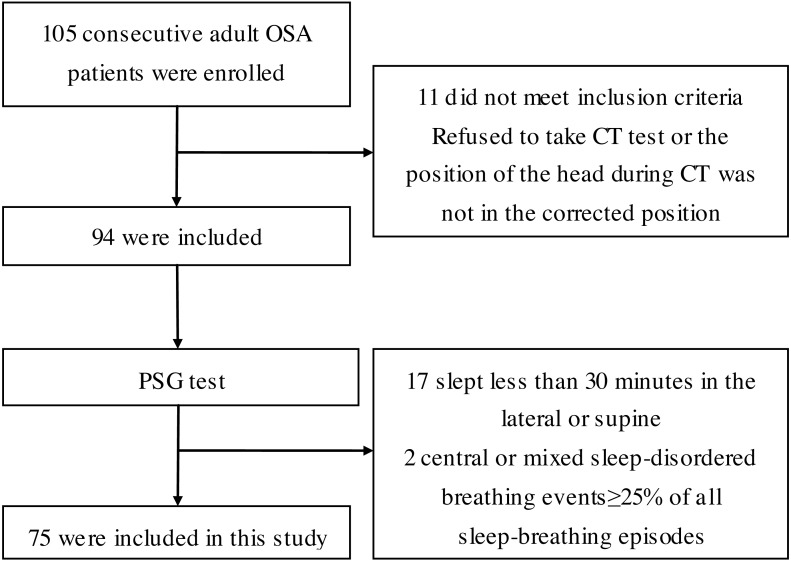
Flow diagram of the recruitment of study participants.PSG test, polysomnography test; CT, computed tomography.